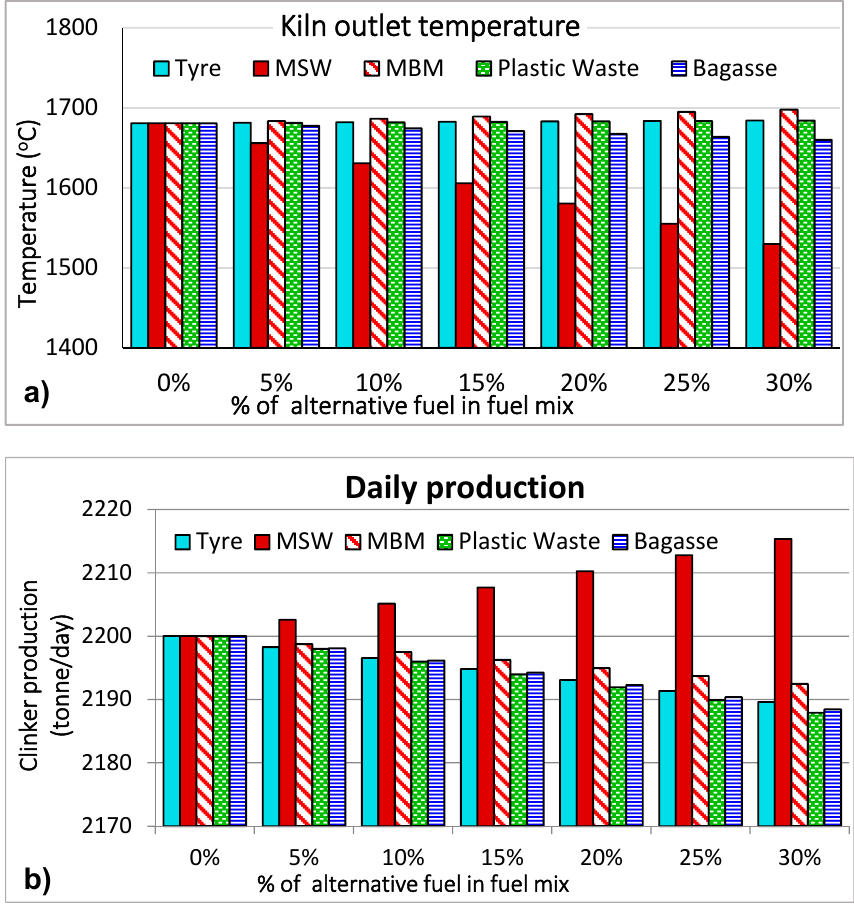
Figure 6. ( a ) Kiln outlet temperature (°C), ( b ) clinker production (tonne/day).